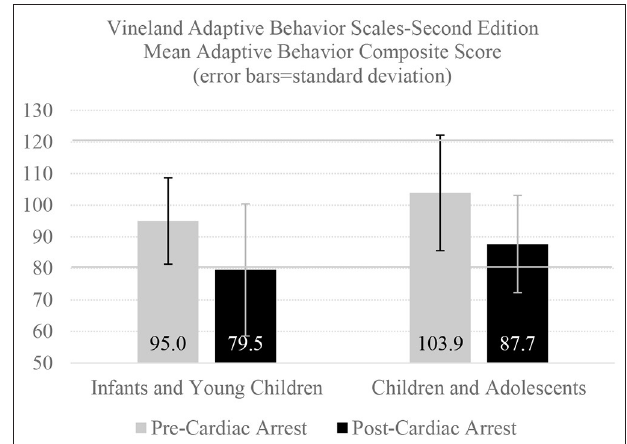
FIGURE 1 | One-year adaptive behavior outcomes following cardiac arrest. There were 146 infants and young children who were enrolled in one of two clinical trials for whom pre-arrest and one-year post-arrest adaptive behavior ratings were completed by parents (median age = 0.5 years, interquartile range = 0.2–1.7, all under the age of 5 at the time of cardiac arrest), as presented in the online supplement (30). There were 49 children and adolescents with pre- and post-arrest adaptive behavior ratings (median age = 13.8 years, interquartile range = 9.2–16.2 at the time of cardiac arrest). The Adaptive Behavior Composite Score has a normative mean of 100 and a standard deviation of 15, so 90% of infants, children, and adolescents in the normative sample would be expected to obtain scores between 80 and 120, demarcated with a solid horizontal line. This figure uses means and SDs presented in Slomine et al.